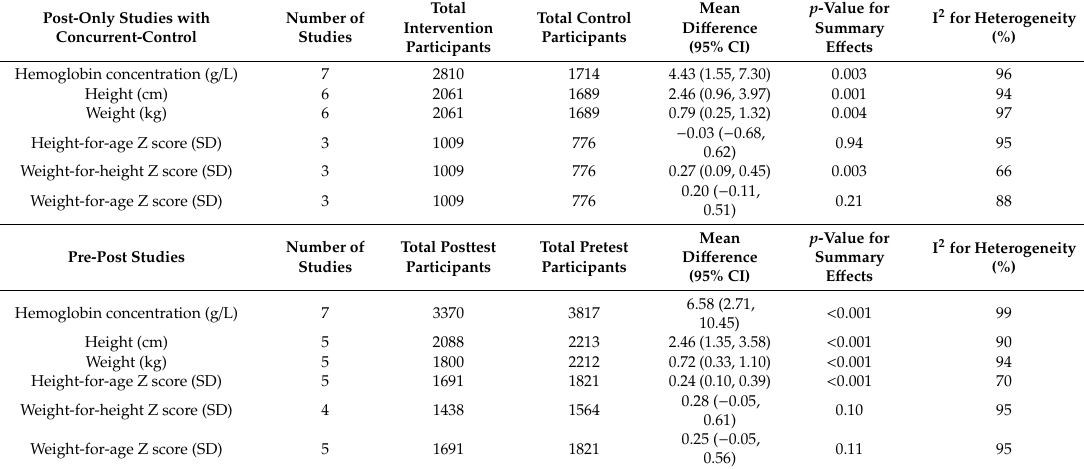
Table 3. The e ff ect of YYB on children’s hemoglobin concentration and continuous, anthropometric outcomes in